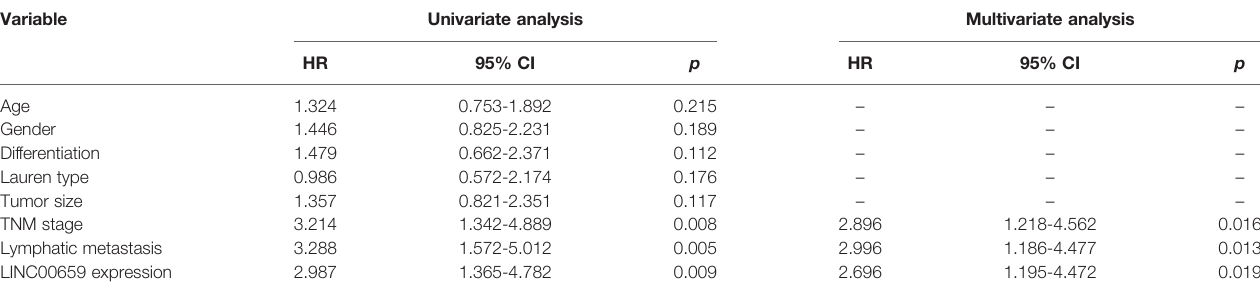
TABLE 3 | Univariate and multivariate Cox proportional hazard model analysis of overall survival and progression-free survival in GC patients.